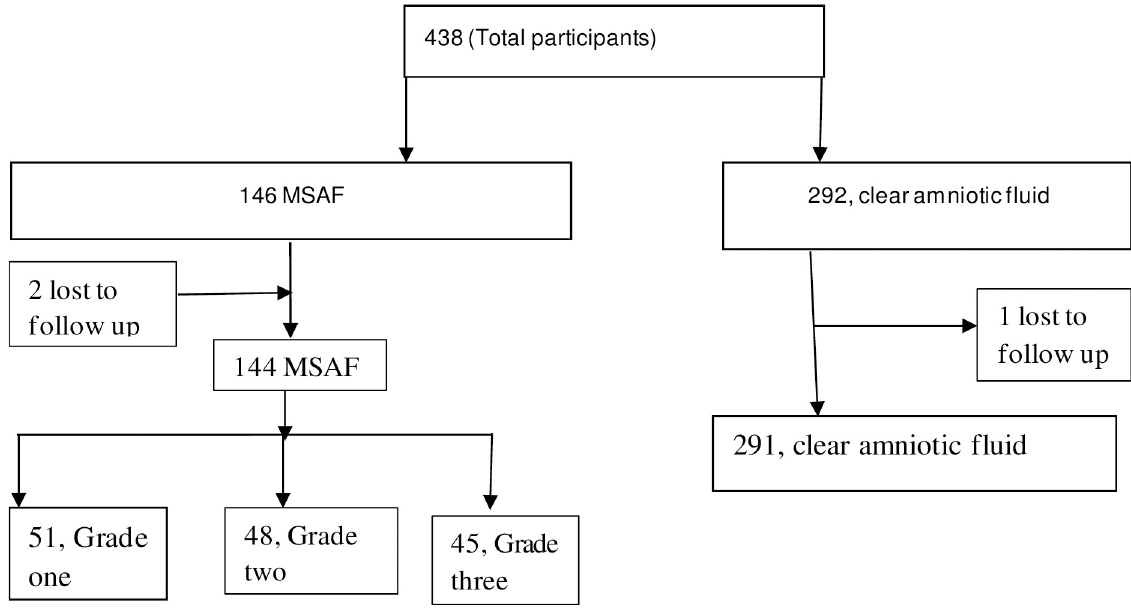
Fig 1. Flow diagram of study